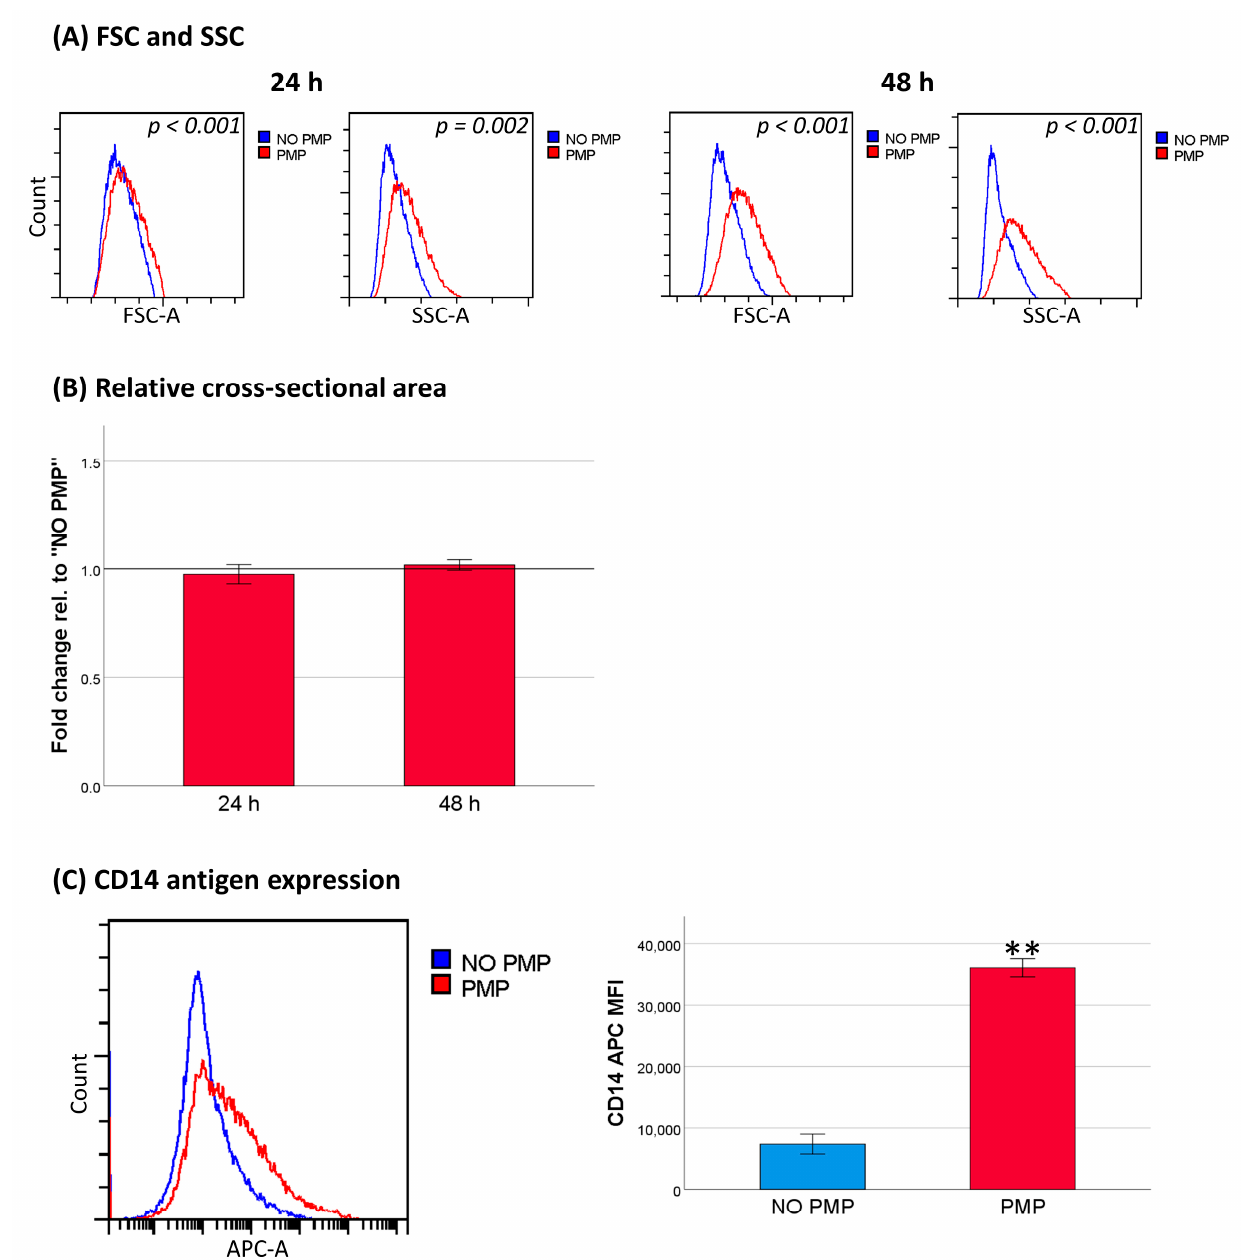
Figure 6. Phenotypical changes induced by platelet microparticles (PMPs) co-incubation. ( A ) Forward scatter (FSC) and side scatter (SSC; n = 4). ( B ) Ratio of cell cross-sectional area ( n = 4). ( C ) CD14 antigen expression after 48 h of culture ( n = 5). Data were compared using the paired-sample t test for data pairs or the one-sample t test for ratios. ** p < 0.001.